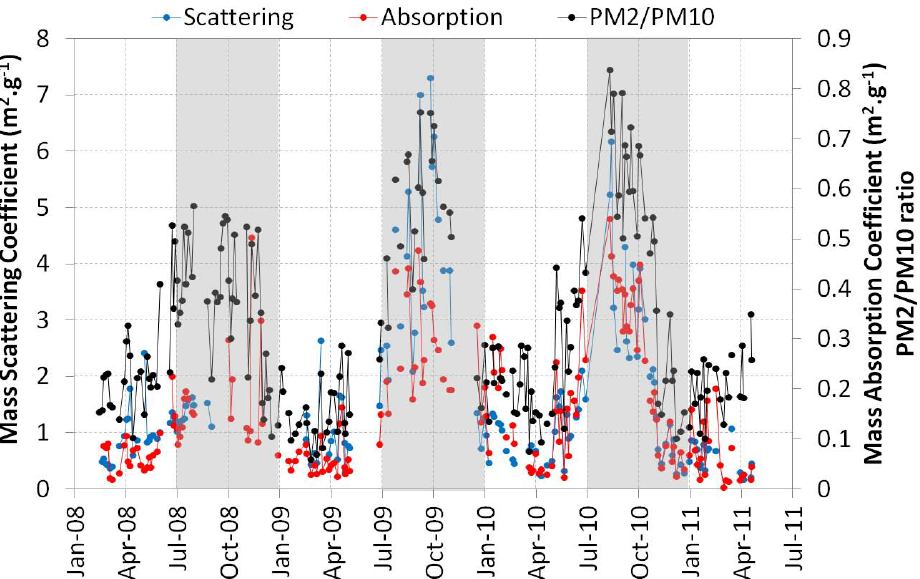
Fig. 10. Time series of particle mass scattering coefficient at 550nm, particle mass absorption coefficient at 637nm, and ratio between PM 2 and PM 10 particle mass, observed from gravimetric analysis of 199 stacked filter units samples. Shaded areas represent the dry season